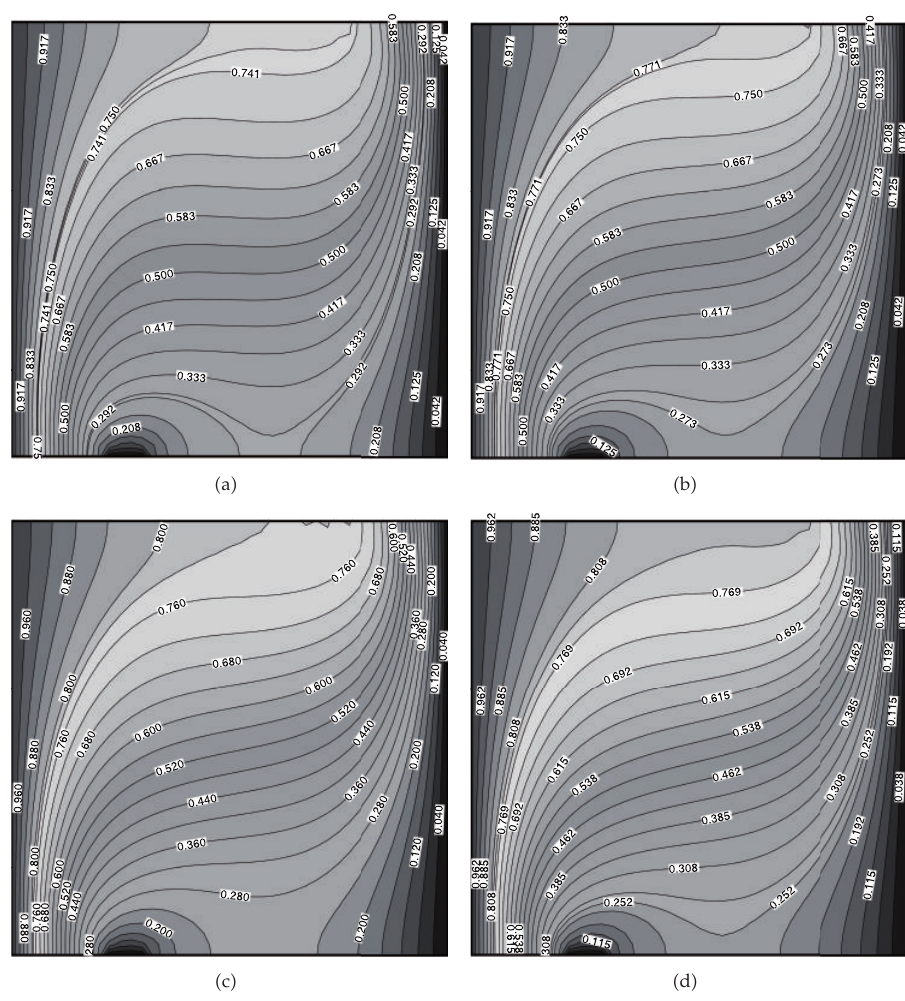
Figure 17: Isotherm contours along the left vertical wall while fixing B (cid:8) 1, D/H (cid:8) 0 . 1, a (cid:8) 0 . 1, Ra (cid:8) 100, S C (cid:8) 0 . 1 for (cid:2) a (cid:3) Le (cid:8) 0 . 25, (cid:2) b (cid:3) Le (cid:8) 0 . 5, (cid:2) c (cid:3) Le (cid:8) 0 . 75, (cid:2) d (cid:3) Le (cid:8) 1 .